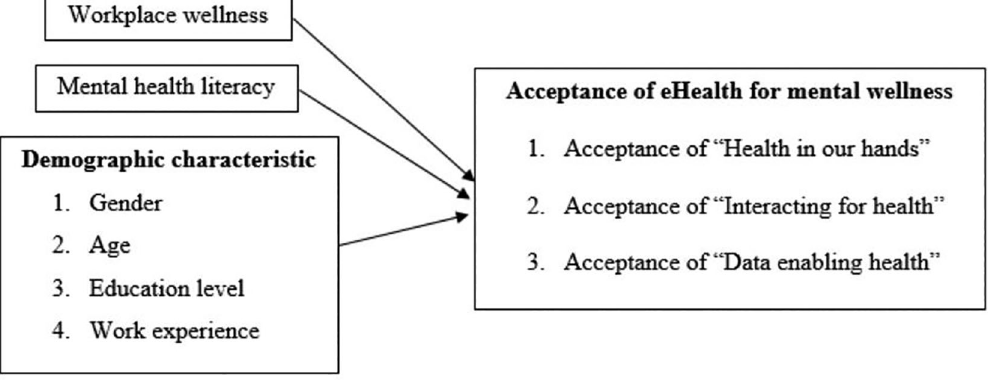
Figure 2. Conceptual framework of the study on acceptance of